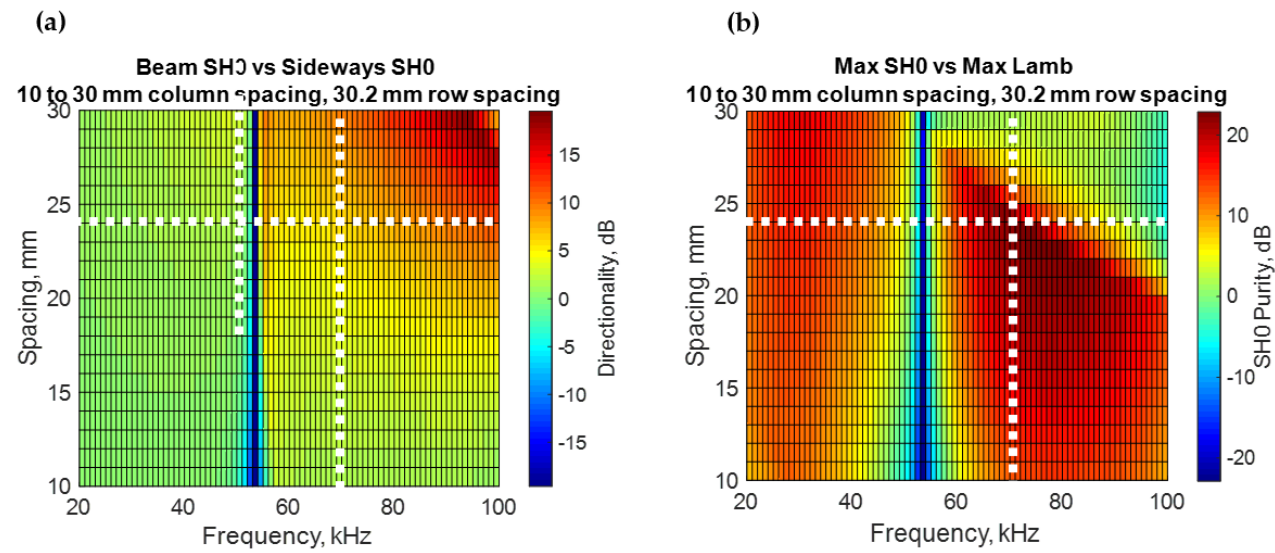
Figure 8. LSA results for 7 × 2 configuration shear transducer array: ( a ) SH 0 directionality and ( b ) SH 0 mode purity.